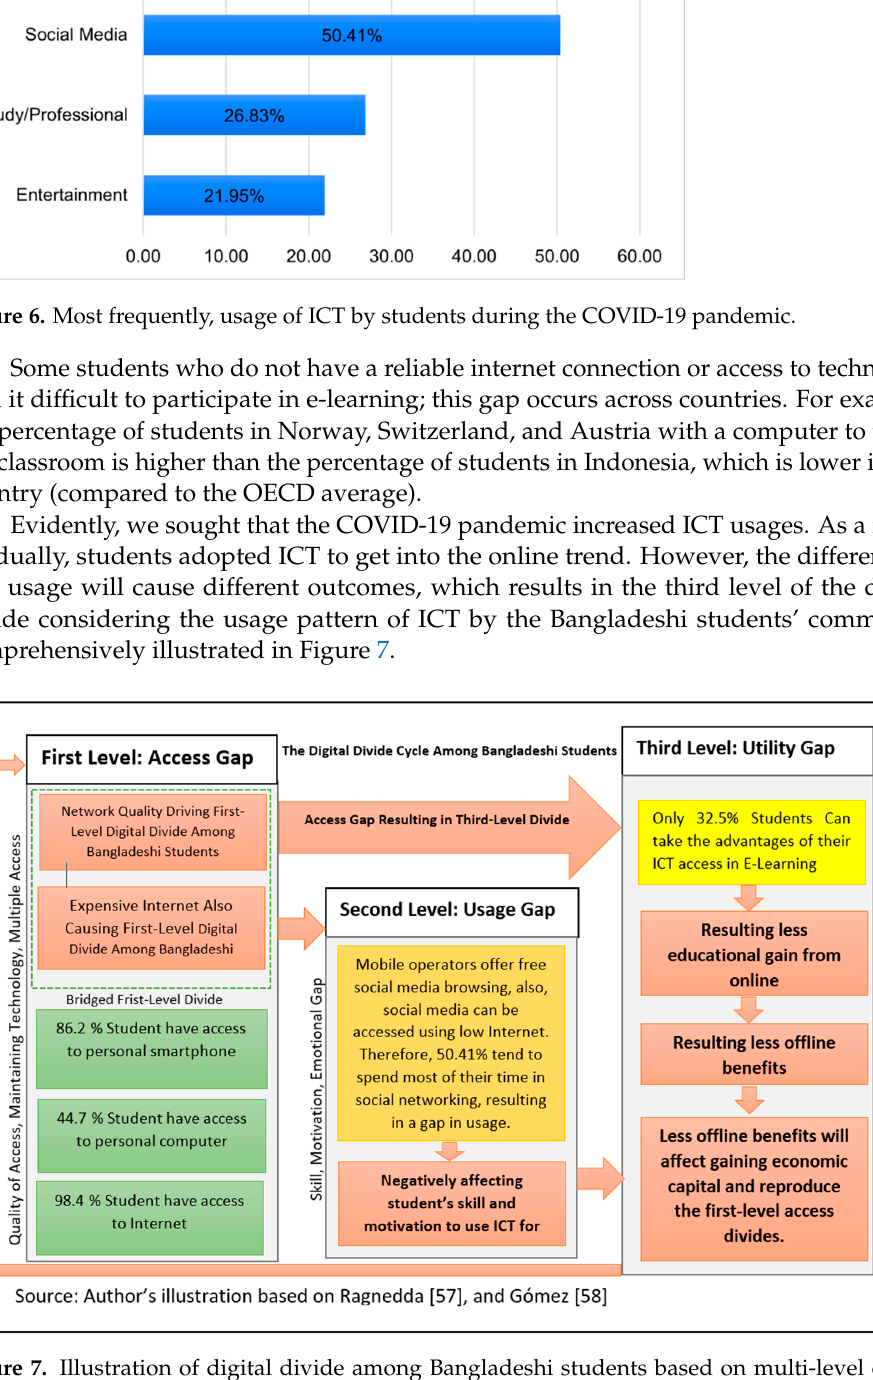
Figure 6. Most frequently, usage of ICT by students during the COVID-19 pandemic.